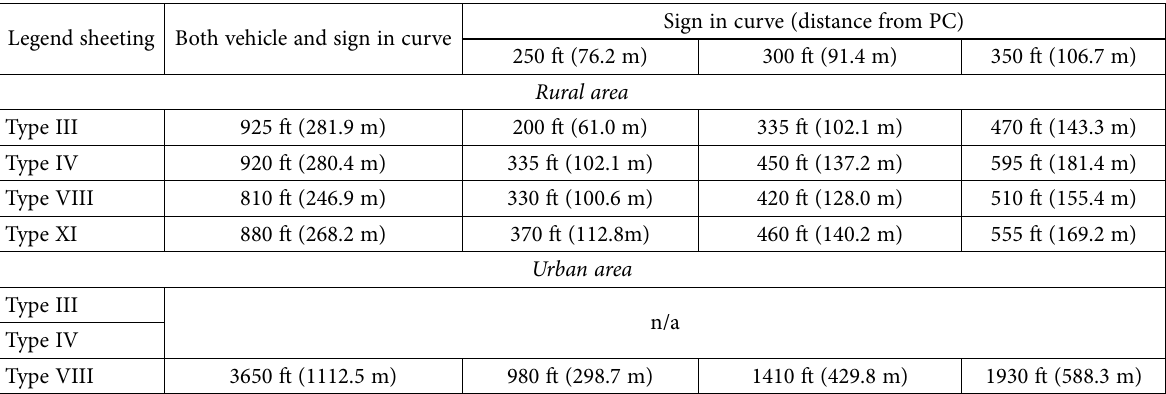
Table 3. Breakpoint radii of horizontal curves in both rural and urban areas Sign in curve (distance from Legend sheeting Both vehicle and sign in curve